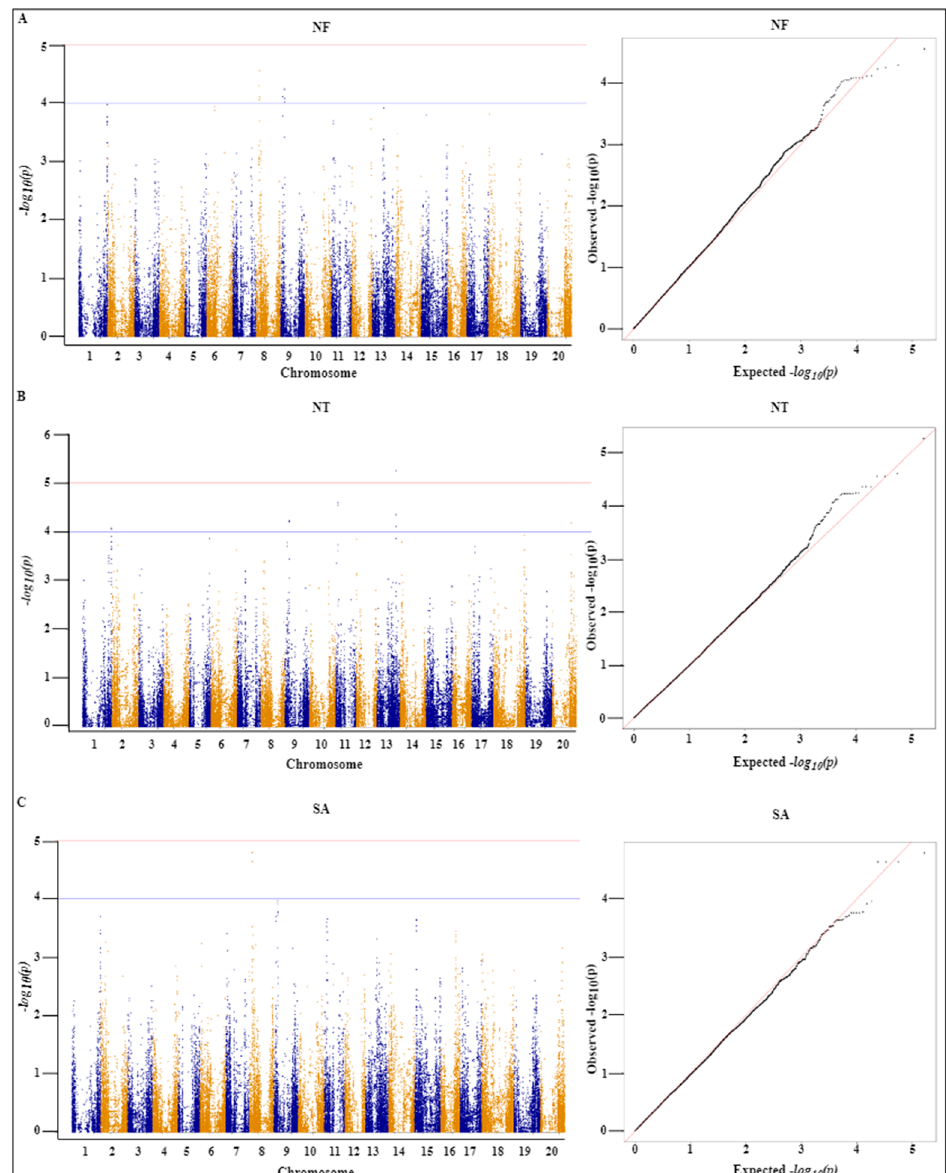
Figure 4. Manhattan and quantile-quantile (QQ) plots of the 357 soybean landraces using the MLM model. ( A ) Number of root forks (NF), ( B ) number of root tips (NT), and ( C ) root surface area (SA). The X-axis represents the chromosome number and the Y-axis represents the − log10 ( p ) value. The threshold of 4.0 (Bonferroni correction) was adopted with the blue line in the Manhattan plots. The Manhattan plot and QQ plot is based on the association of 84,210 chromosomal SNPs with DIAM and LAD traits.